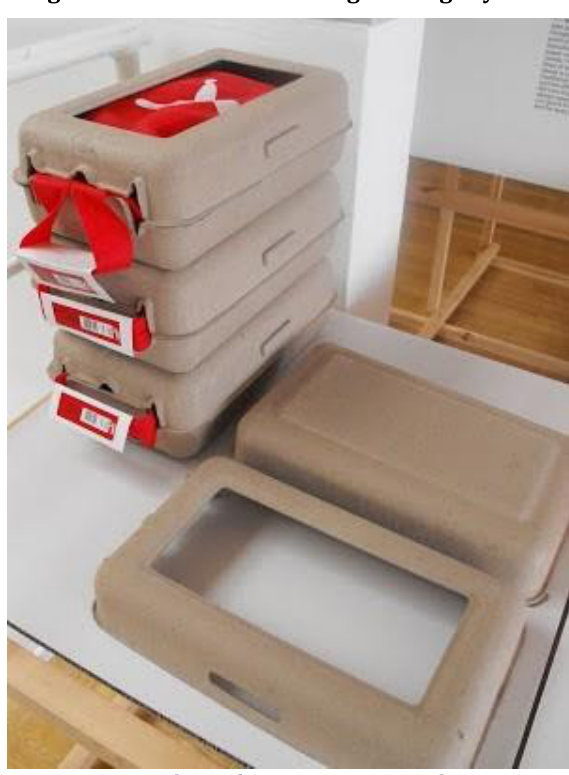
Figure 2: The clever little bag - storage system